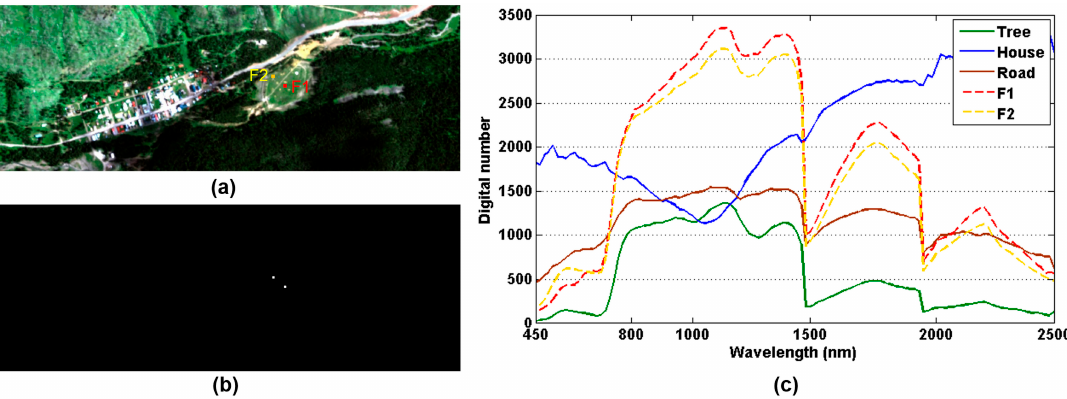
Figure 6. ( a ) The image scene of HyMap dataset; ( b ) ground truth map of F1 and F2 anomalies; and ( c ) spectral curves of main background objects and anomalous signature.